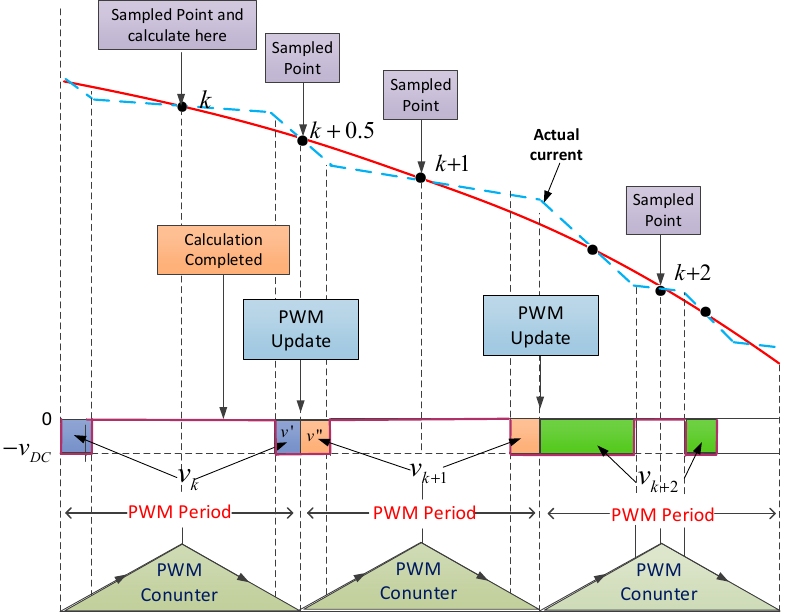
Figure 4. Duty ratio predicted at current descending region. PWM: pulse width modulation.